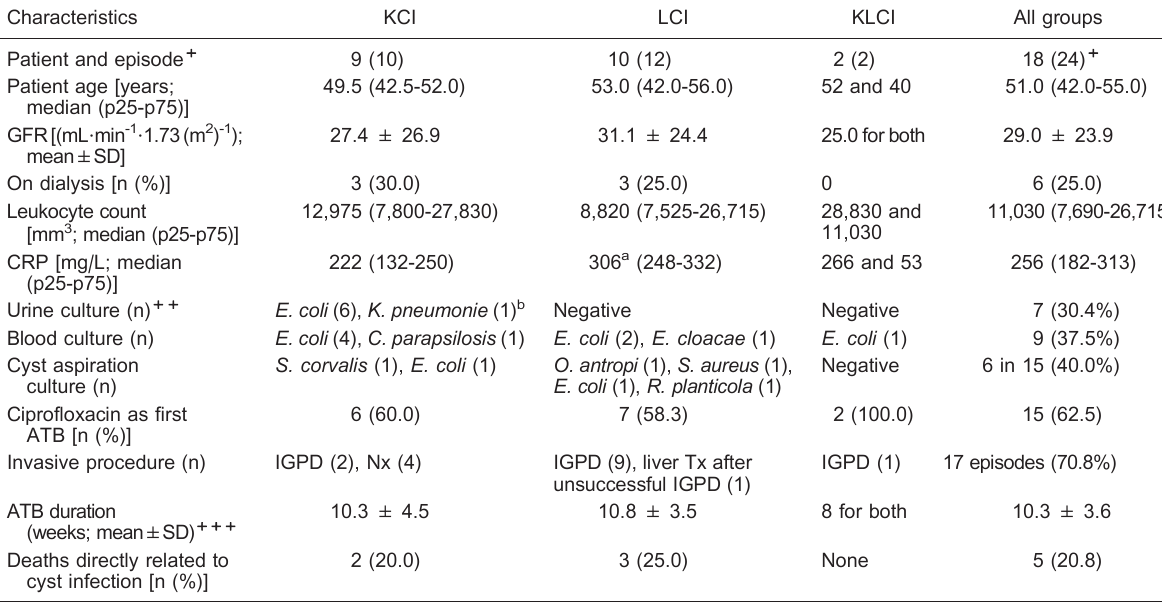
Table 2. Clinical features of cyst infection episodes in patients with autosomal dominant polycystic kidney disease/autosomal dominant polycystic liver disease.